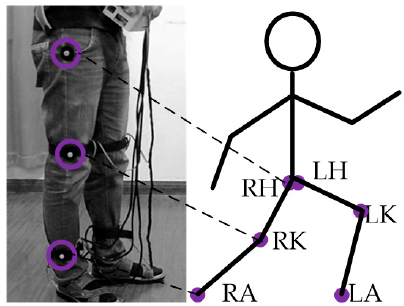
Figure 3. Marker points employs (R: right, L: left, H: hip joint, K: knee joint and A: ankle joint).